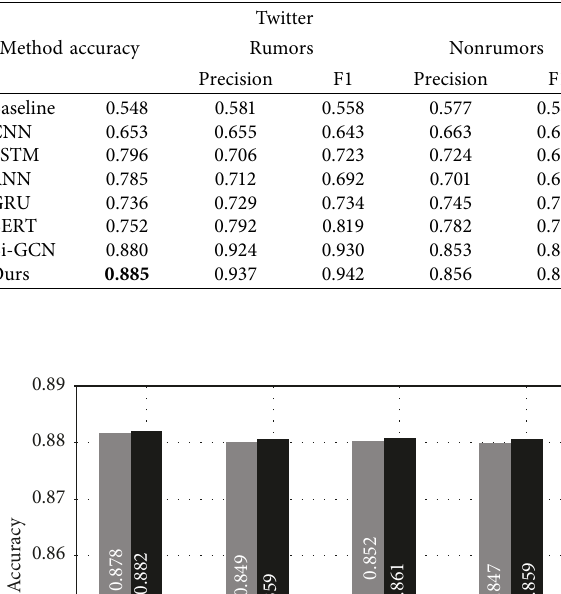
Table 4: Comparison of detection accuracy on Twitter.